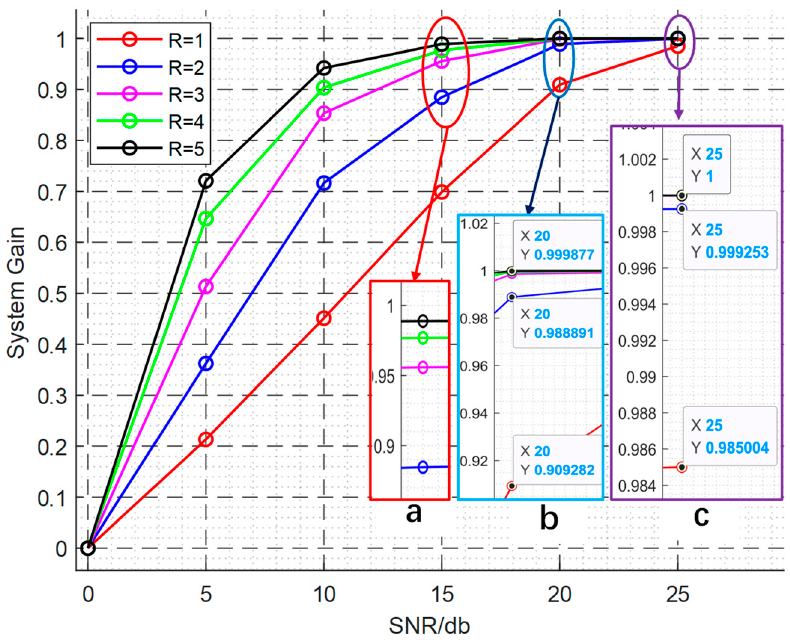
Figure 5. Simulation comparison of system gain variation for different number of relay nodes. ( a ) Comparison of System Gain amplification with SNR of 15 db. ( b ) Comparison of System Gain amplification with SNR of 20 db. ( c ) Comparison of System Gain zoomed in with SNR of 25